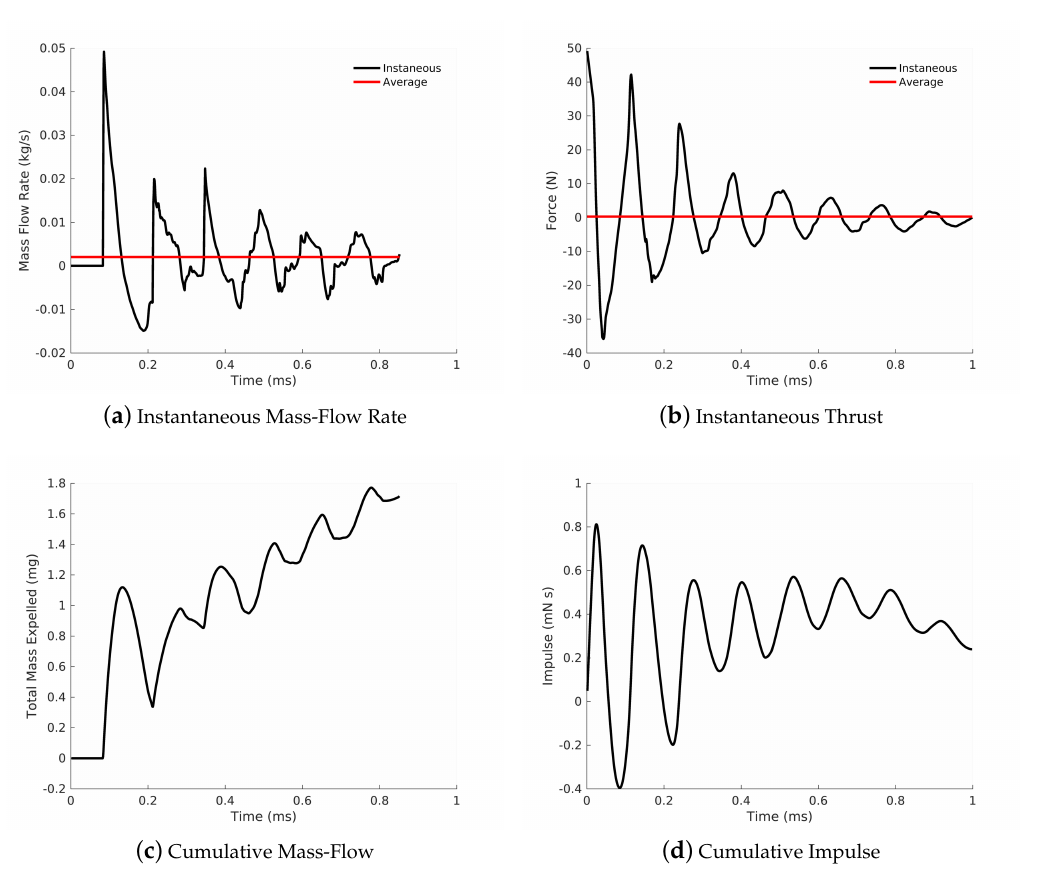
Figure 11. Simulated nozzle performance as a function of